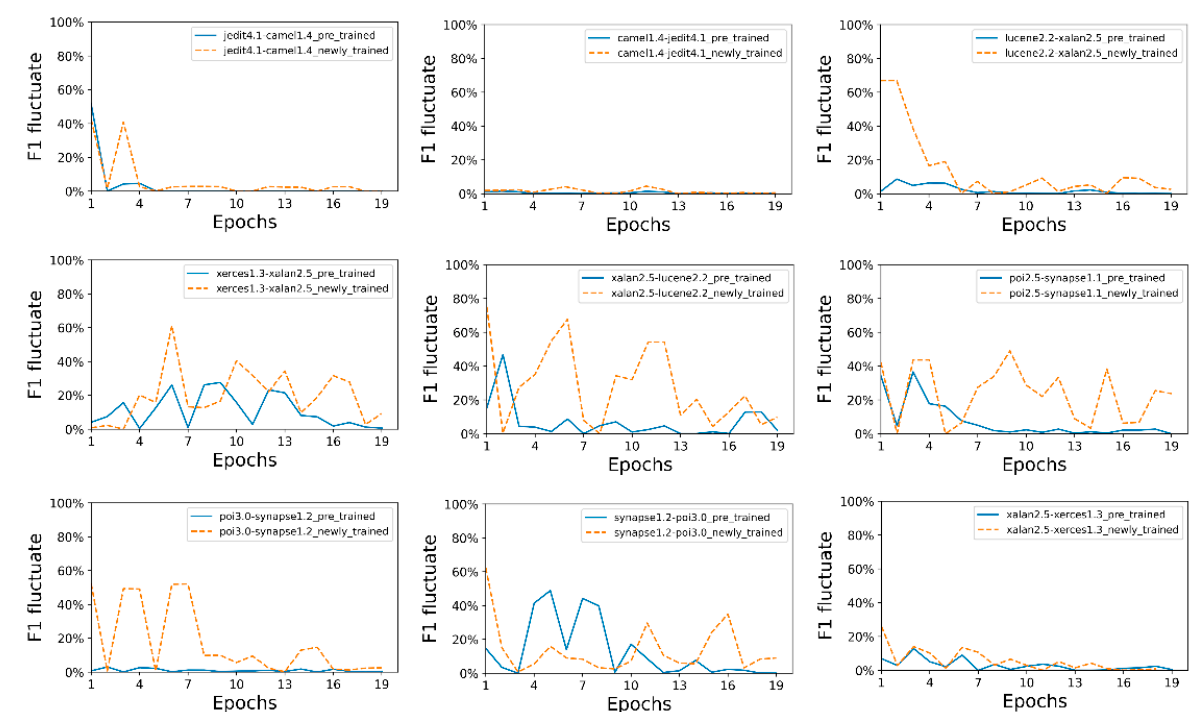
Figure 7. The fluctuating level of F-measure on CodeBERT-PT and CodeBERT-NT on the CPPSC dataset for cross-project defect prediction.